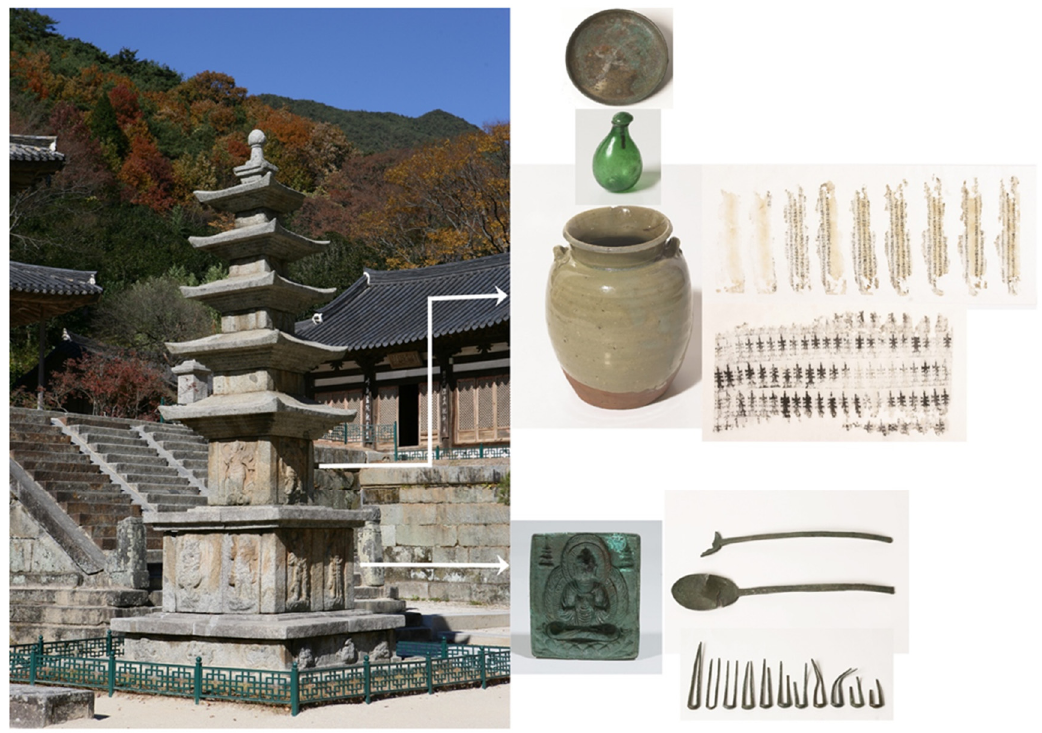
Figure 2. Hwa ŏ msa western stone pagoda and objects excavated [©CBM, Lim edit]. Figure 2. Hwa˘omsa western stone pagoda and objects excavated [ © CBM, Lim